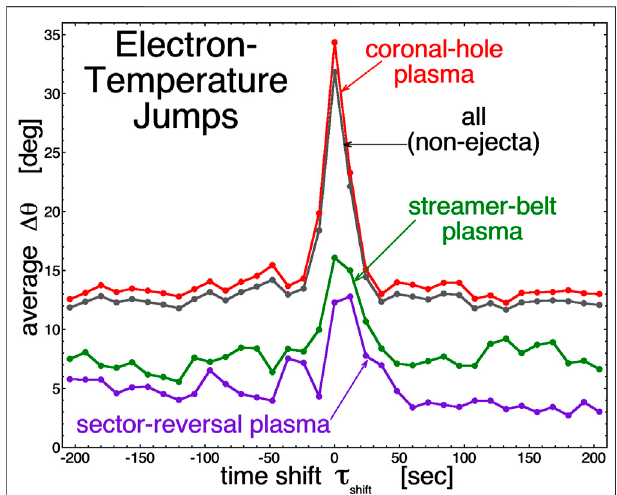
FIGURE 4 | The superposed epoch average value of the 30-s change in the magnetic- fi eld direction is plotted as a function of time from the identi fi ed core-electrontemperatureboundariesintheWINDdatasetat1AU.Notethat the statistics of the purple sector-reversal-region-plasma curve are poor with only 29 identi fi ed temperature-boundary